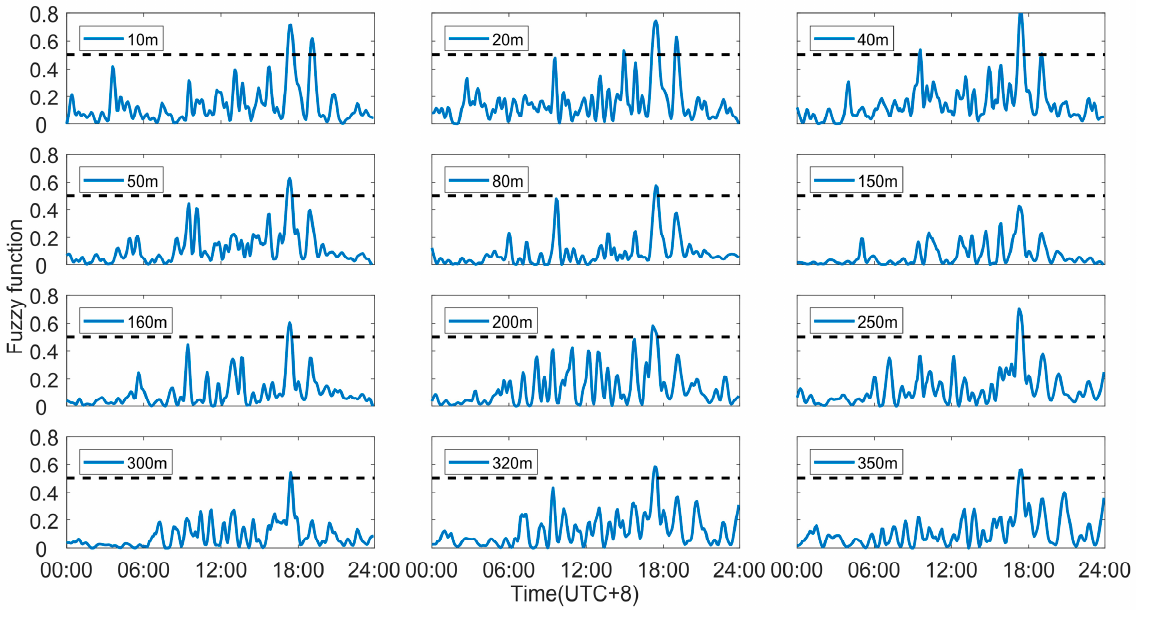
Figure 9. The total fuzzy function of wind, temperature, and relative humidity elements at different heights on the tower on 25 September 2019.